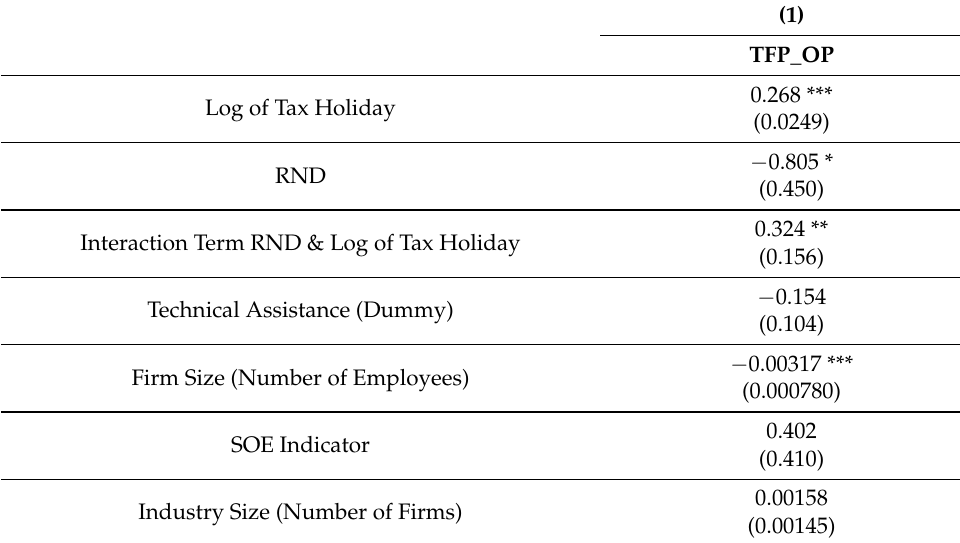
Table A7. Robustness Checks on R&D Intensity by Dropping Values of